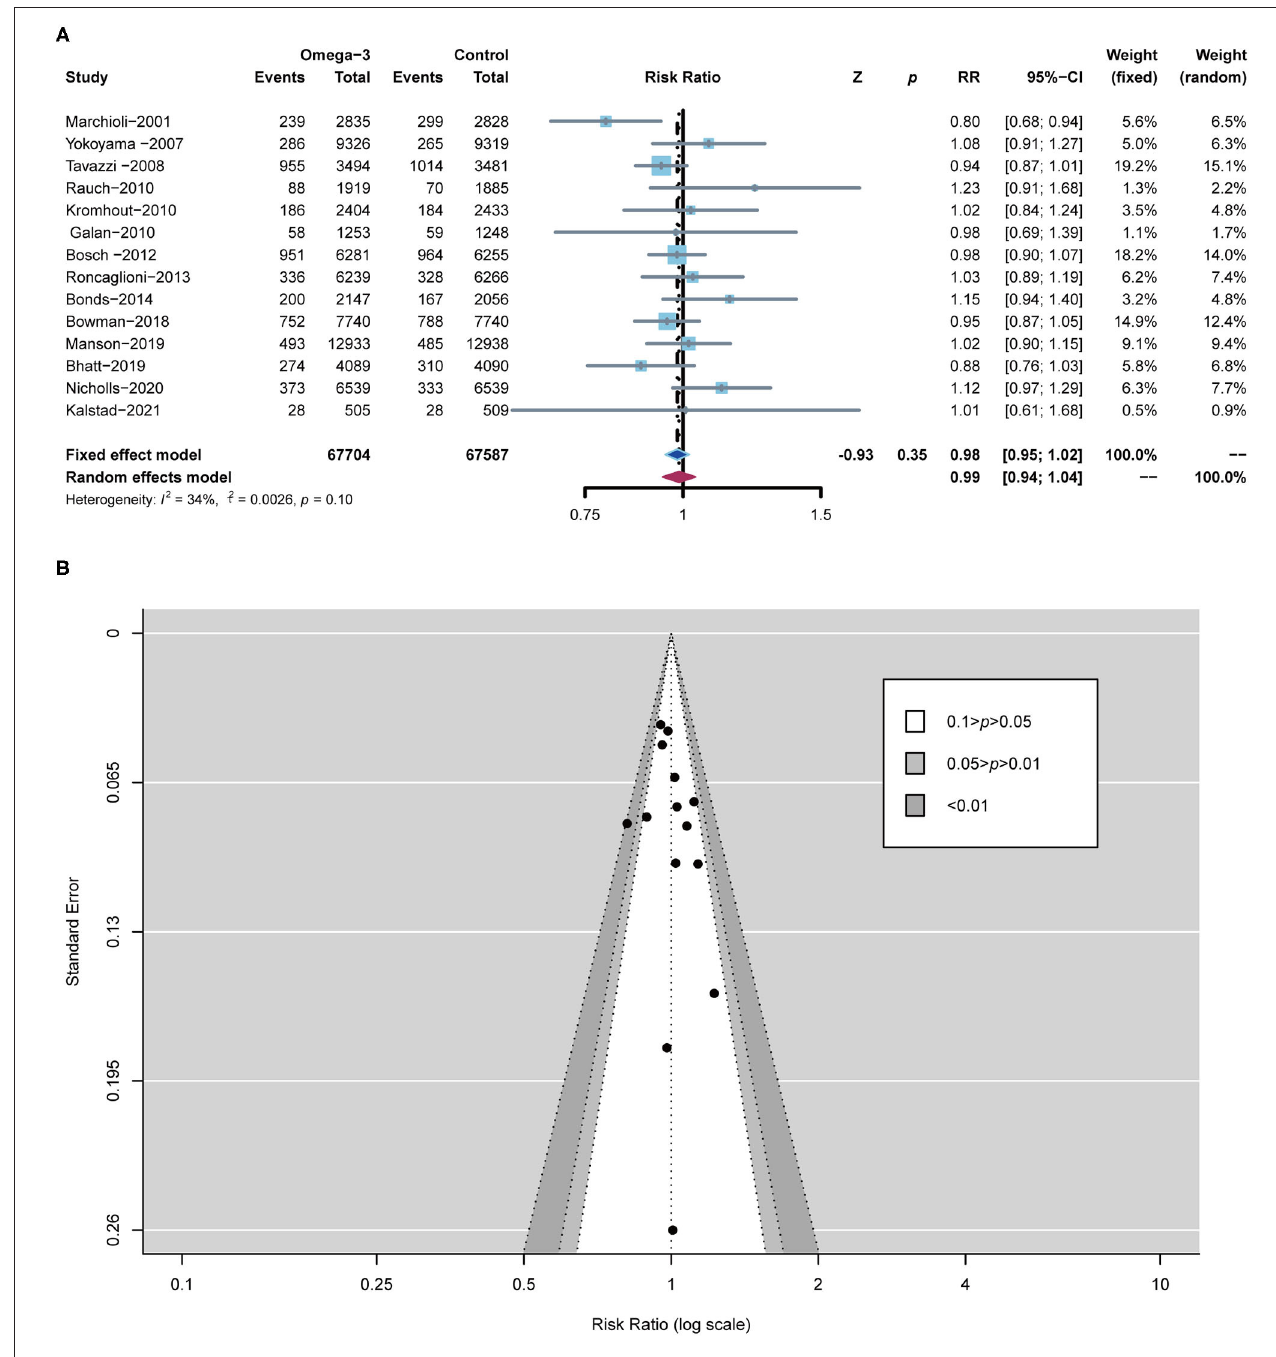
FIGURE 3 | Forest plot of all-cause death and the detection of publication bias. (A) Forest plot of all-cause death; (B) funnel chart.